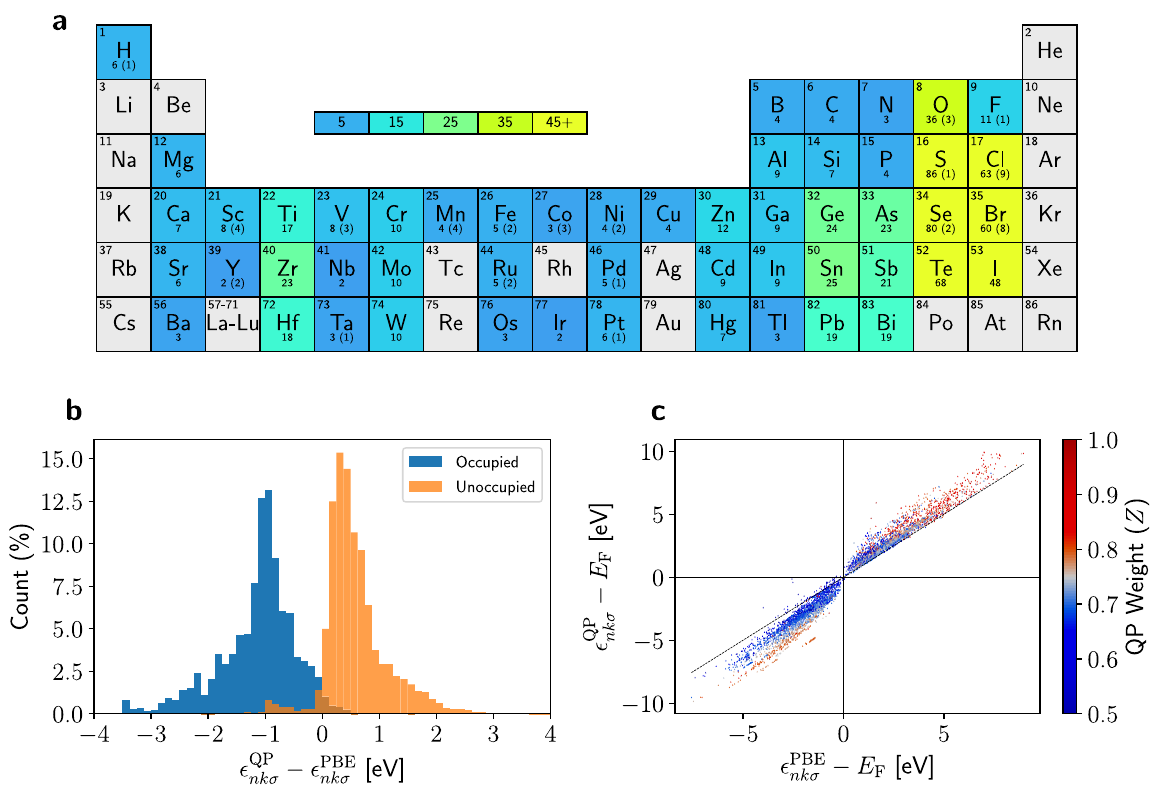
Fig. 1 The G 0 W 0 data set. a The representation of individual elements in the G 0 W 0 data set. The number of materials containing a given element is shown under the element ’ s symbol. The number of magnetic materials, if any, is shown in the parenthesis next to the total number. b Histograms of quasiparticle energy corrections calculated from G 0 W 0 . The blue histogram shows the three topmost occupied valence bands, while the orange shows the three lowest unoccupied conduction bands. c A scatter plot of the PBE energy vs. the G 0 W 0 energy. The colors show the Z value truncated to the interval [0.5, 1.0]. The points are plotted so that a point with smaller Z is plotted on top of a point with larger Z if the two points overlap.